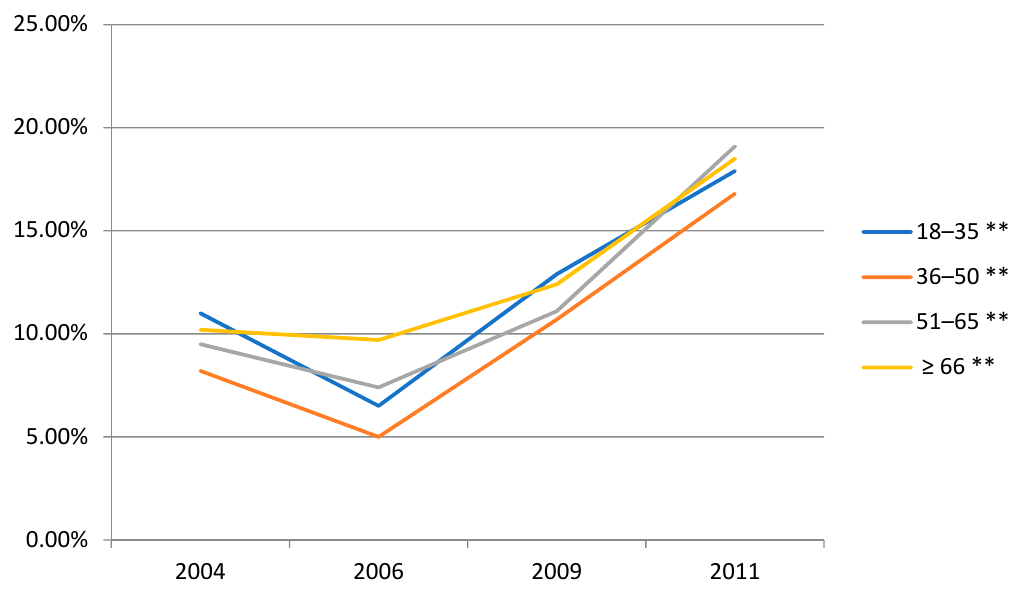
Figure 3. Time trends in the prevalence of alcohol consumption (wine) amongst male drinkers by age groups, CHNS. ** Statistically significant ( p < 0.01).